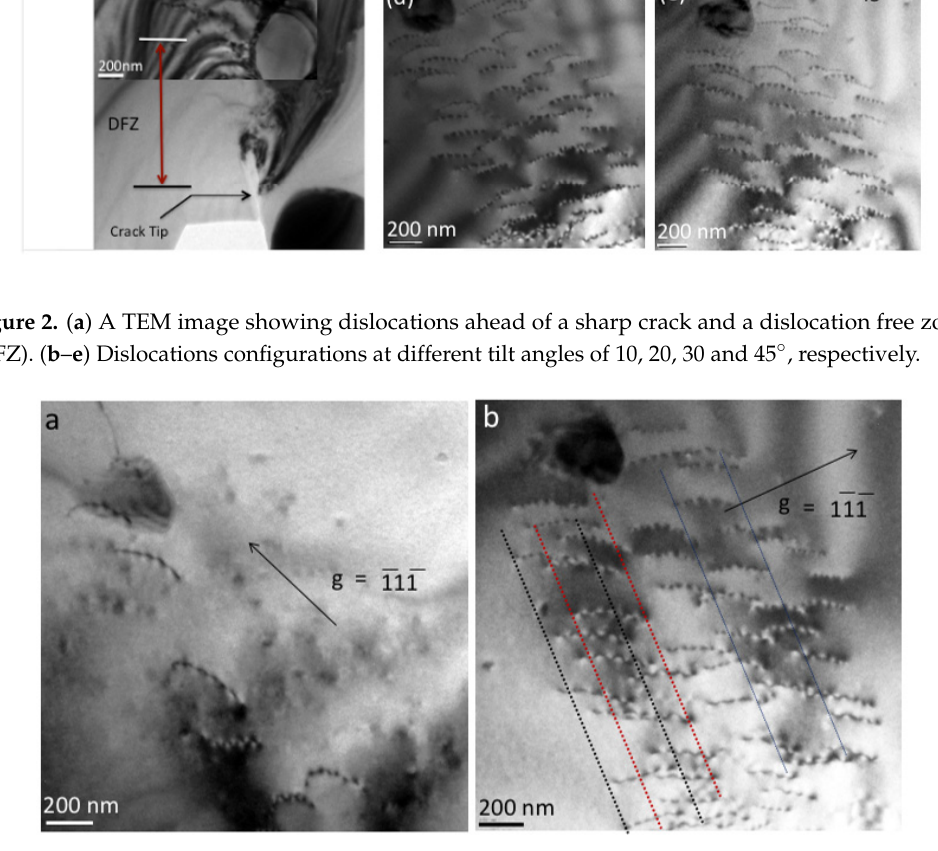
Figure 3. ( a , b ) Two beam bright field images showing dislocations with g = ¯11¯1 and g = 1¯1¯1,